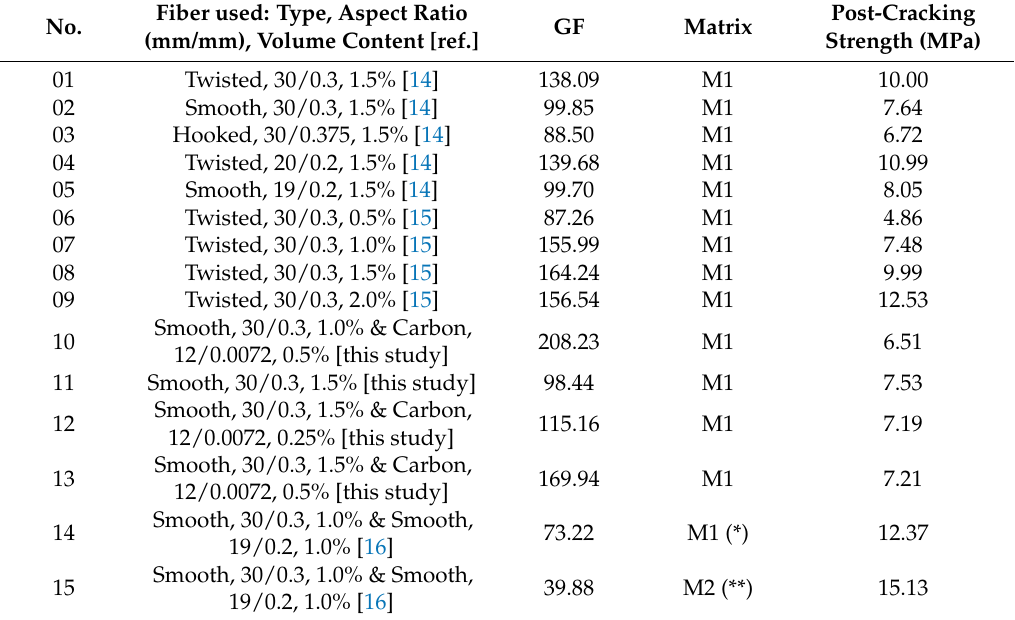
Table 8. Gauge factors of strain-hardening composites using various conductive discrete fiber.